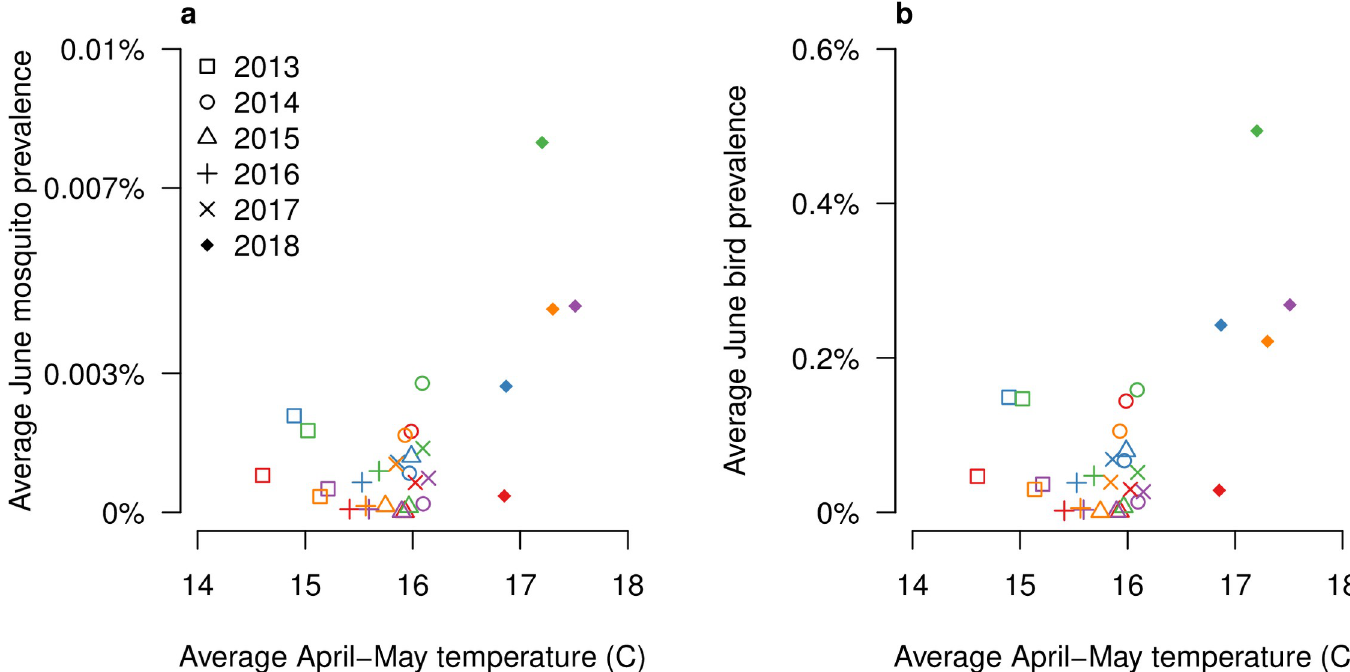
Fig 5. Estimated prevalences VS spring temperatures. Estimated average June mosquito (panel a) and avian (panel b) prevalence (Y-axis) versus spring average temperatures in degrees Celsius (X-axis). Colors represent the cluster division (A: red, B: blue, C: green, D: purple, E: orange).